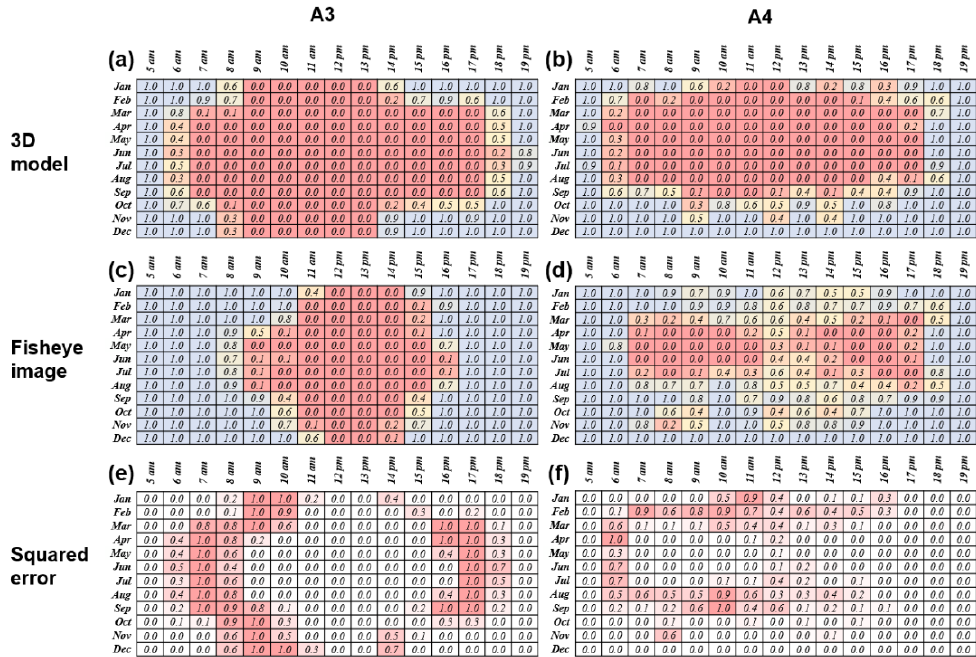
Figure 11. Shading matrices obtained at survey points A3 and A4 using 3D models ( a , b ) and fisheye images ( c , d ), respectively. Squared error matrices between two shading matrices at survey points ( e ) A3 and ( f ) A4.